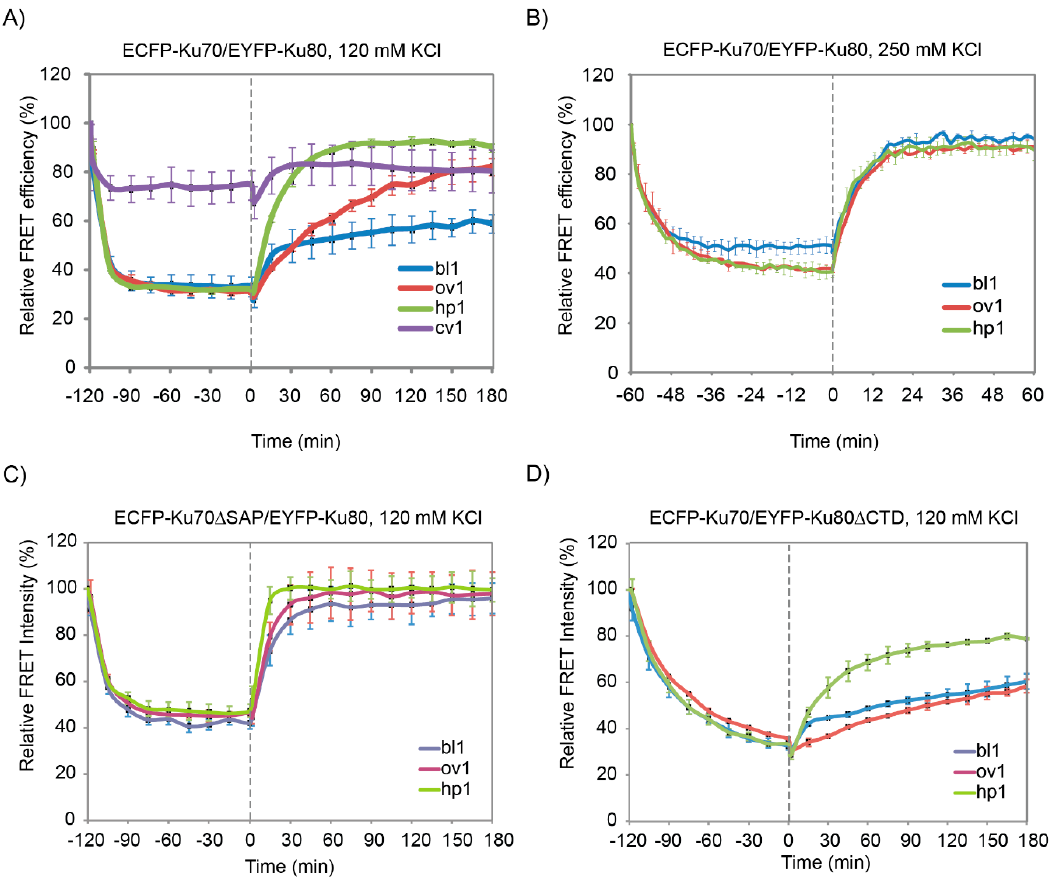
Figure 2. Recovery of the FRET signal after incubation of Ku-DNA complexes with untagged Ku70/80. ( A ) ECFP-Ku70/EYFP-Ku80 was first incubated with the indicated oligonucleotide substrates (between time points -120 and 0), after which a 3-fold excess of untagged Ku70/80 was added to the mixtures, and FRET efficiency was determined at the indicated time points. ( B ) The same analysis as in A, but with 250 mM KCl instead of 120 mM KCl (also note the different time scale). Error bars depict the SEM. ( C ) ECFP-Ku70 Δ SAP/EYFP-Ku80 or ( D ) ECFP-Ku70/EYFP-Ku80 Δ C was incubated with the indicated DNA substrates and challenged with excess untagged Ku70/Ku80 protein at time point 0.